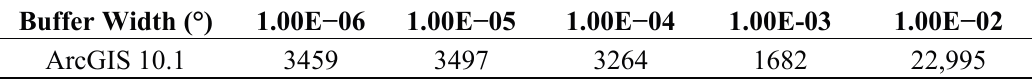
Table 1. Time of buffer operation in ArcGIS 10.1 with five buffer widths: (s).